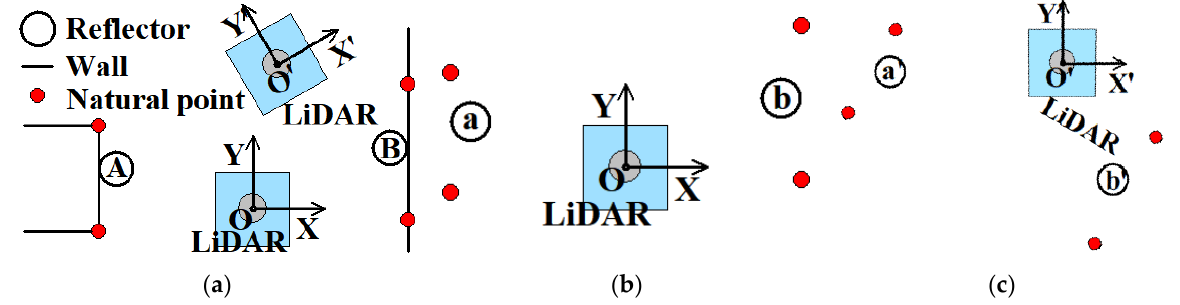
Figure 14. Schematic diagram of the reflector positioning method with one or two reflectors. ( a ) Add natural feature points to the initial set when detected reflectors are insufficient. ( b ) Scanning results of the first frame after natural points are added. ( c ) Scanning results of the second frame after natural points are added.